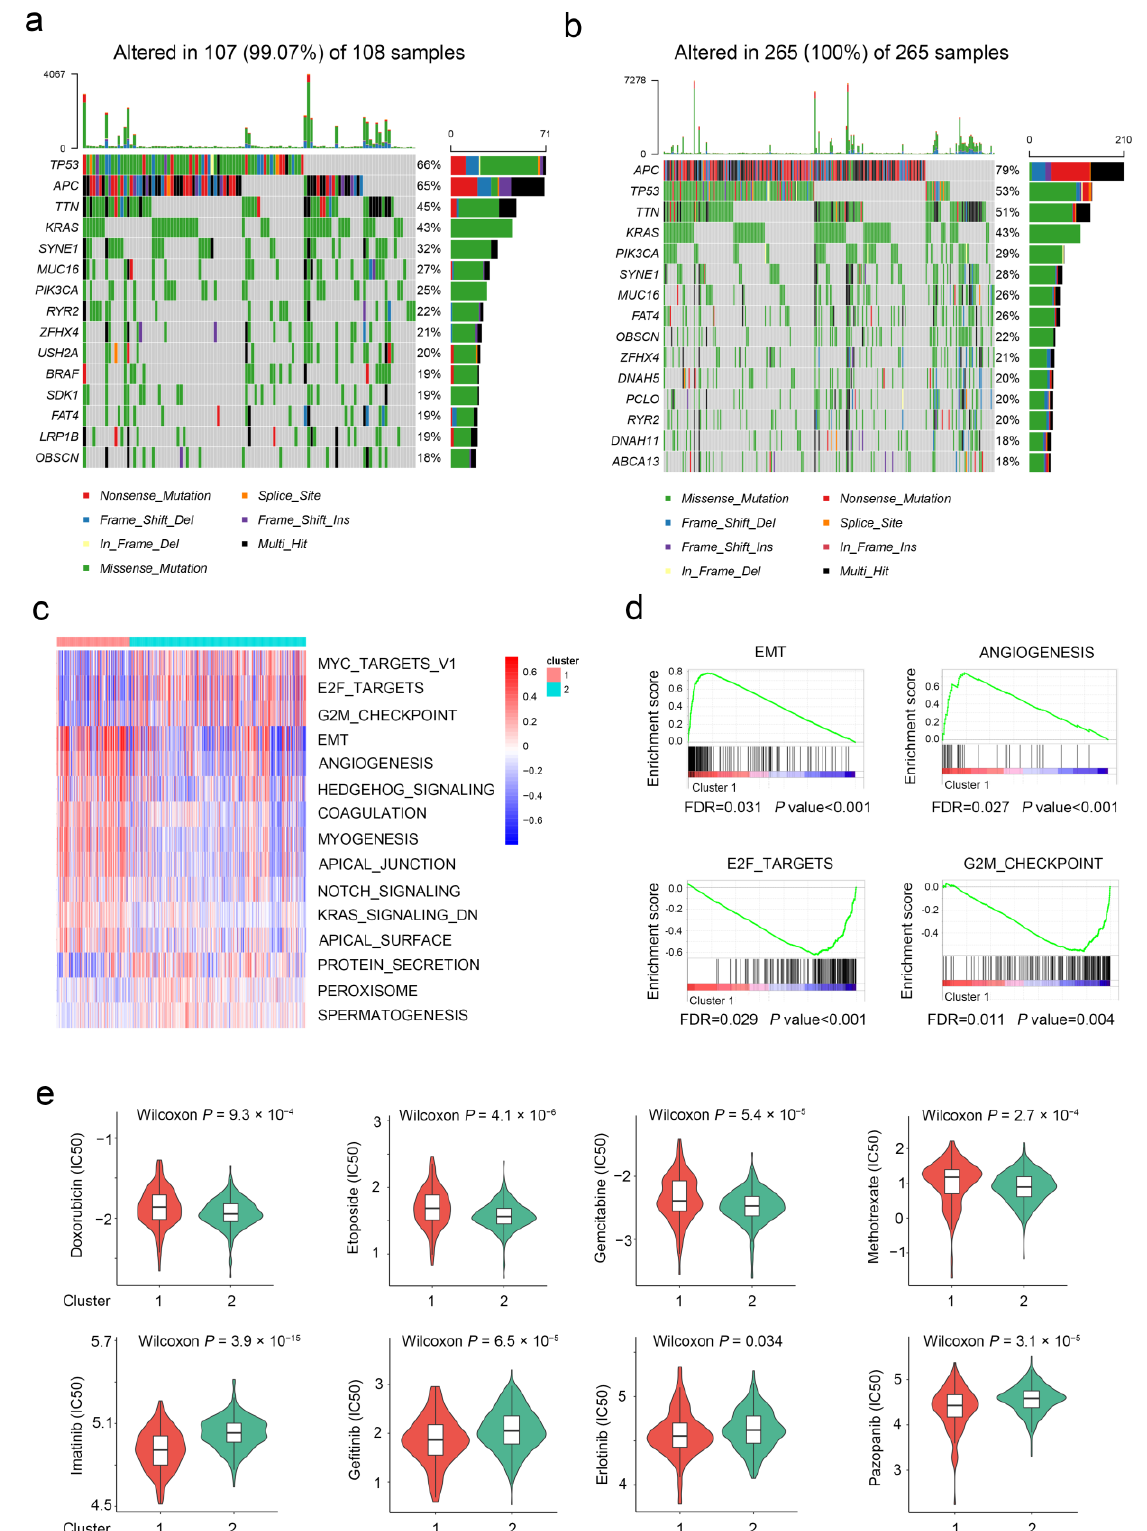
Figure 3. Molecular characteristics of different aging subgroups. ( a ) Landscape of genomic aberra- tions of cluster 1. ( b ) Landscape of genomic aberrations of cluster 2. ( c , d ) GSVA and GSEA analyzed the biological pathways of two aging subtypes. ( e ) Eight common therapeutic drugs with differential IC50 between two aging